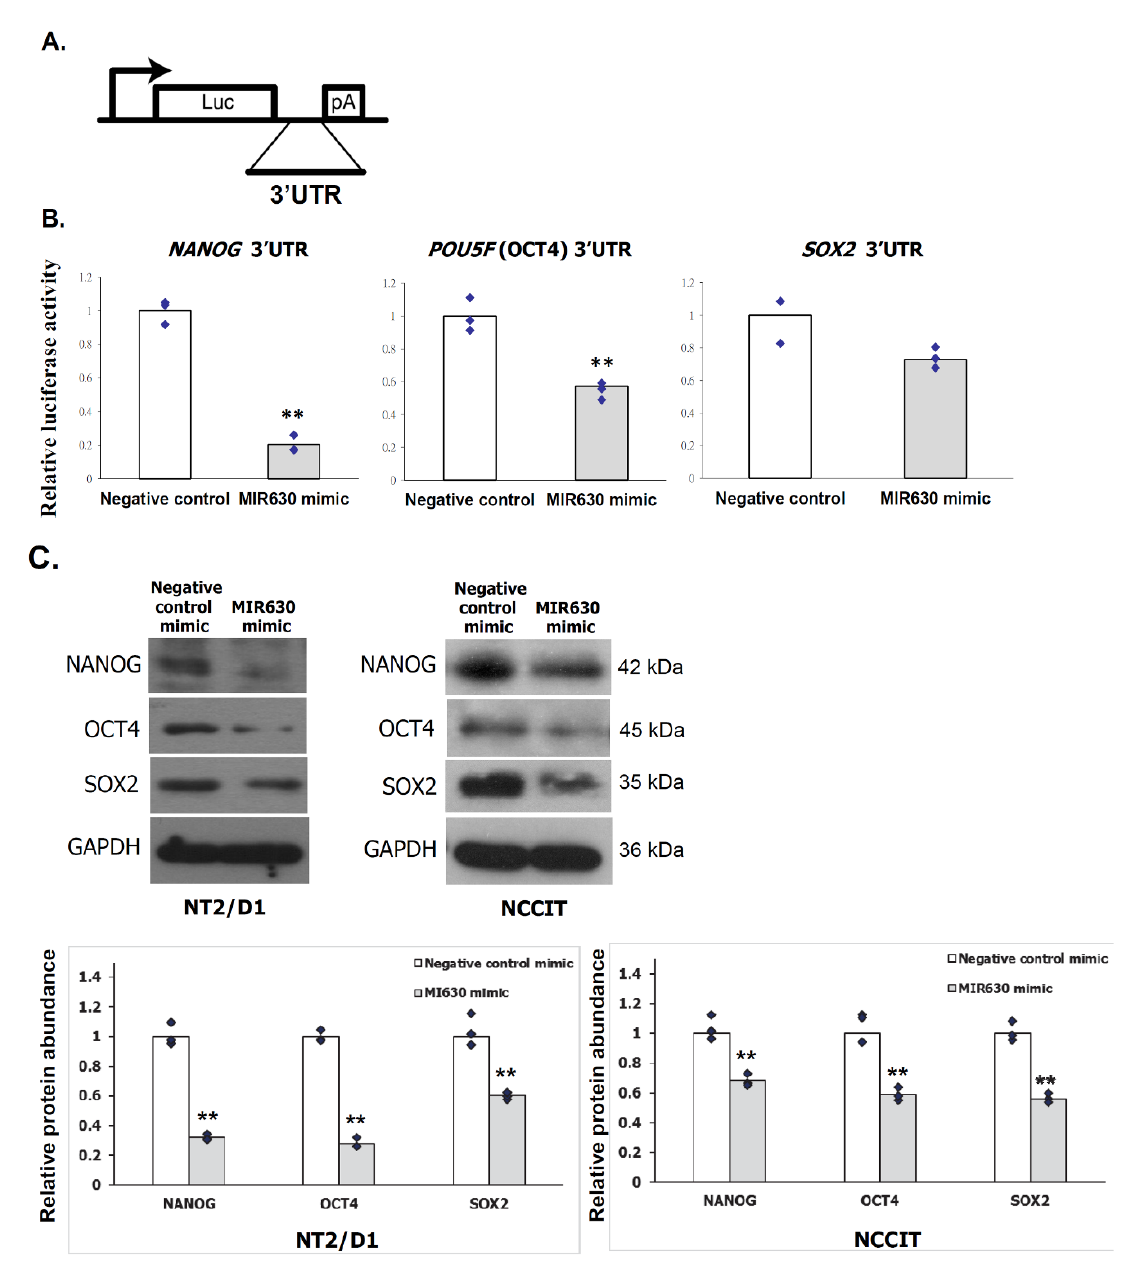
Figure 1. MIR630 specifically represses the reporter activity of its targets in the luciferase assay in embryonal carcinoma cells. ( A ). Structure of the 3 ′ UTR reporters. Luc, firefly luciferase; pA, polyadenylation signal. ( B ). NT2/D1 cells were co-transfected with 30 nM MIR630 mimic and a luciferase reporter containing the 3 ′ UTR. Two-tailed Student’s t-test was used for comparisons, where ** denotes p < 0.01. ♦ represent data points in Figure 1. ( C ). NT2/D1 cells and NCCIT cells were transfected with negative control miRNA or MIR630 mimic for 24 h. Total cell lysate was analyzed by Western blotting with antibodies against GAPDH, NANOG, OCT4, or SOX2. GAPDH was used to indicate that each lane was loaded with an equal amount of protein. Double asterisk indicates a significant difference between negative control mimic-transfected cells and MIR630 mimic-transfected cells. ( p < 0.01, t-test).